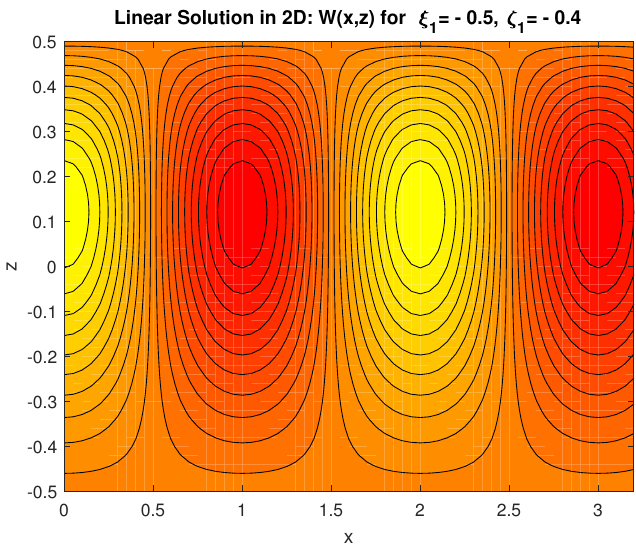
Figure 14. Linear 2D solution for W , i.e., (cid:101) ( W 10 ( x , z ) + δ W 11 ( x , z )) . The linear solution (cid:101) ( θ 10 ( x , z ) + δθ 11 ( x , z )) is shown in Figure 15.